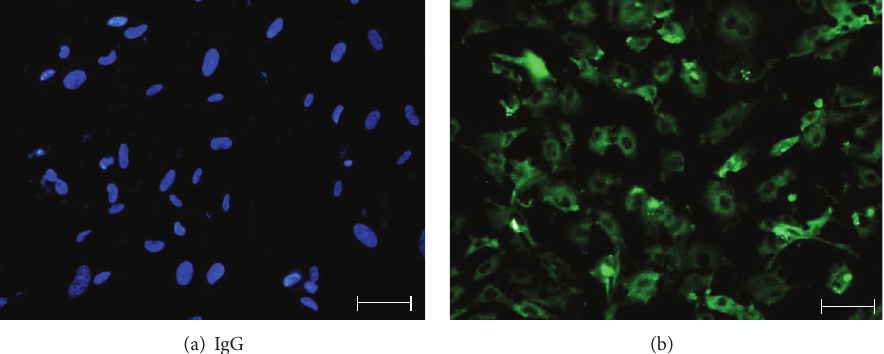
Figure 2: (a) Negative control for staining IgG in MSCs. The negative control for detecting cTnT expression in MSCs after induction for two weeks. Scale bar = 50 𝜇 m. (b) Identification of cardiomyocytes. Purified cardiomyocytes derived from new-born rats’ heart tissue were identified by immunoflourescence assay. Immunofluorescence staining of cTnT in cardiomyocytes was positive. Scale bar = 10 𝜇